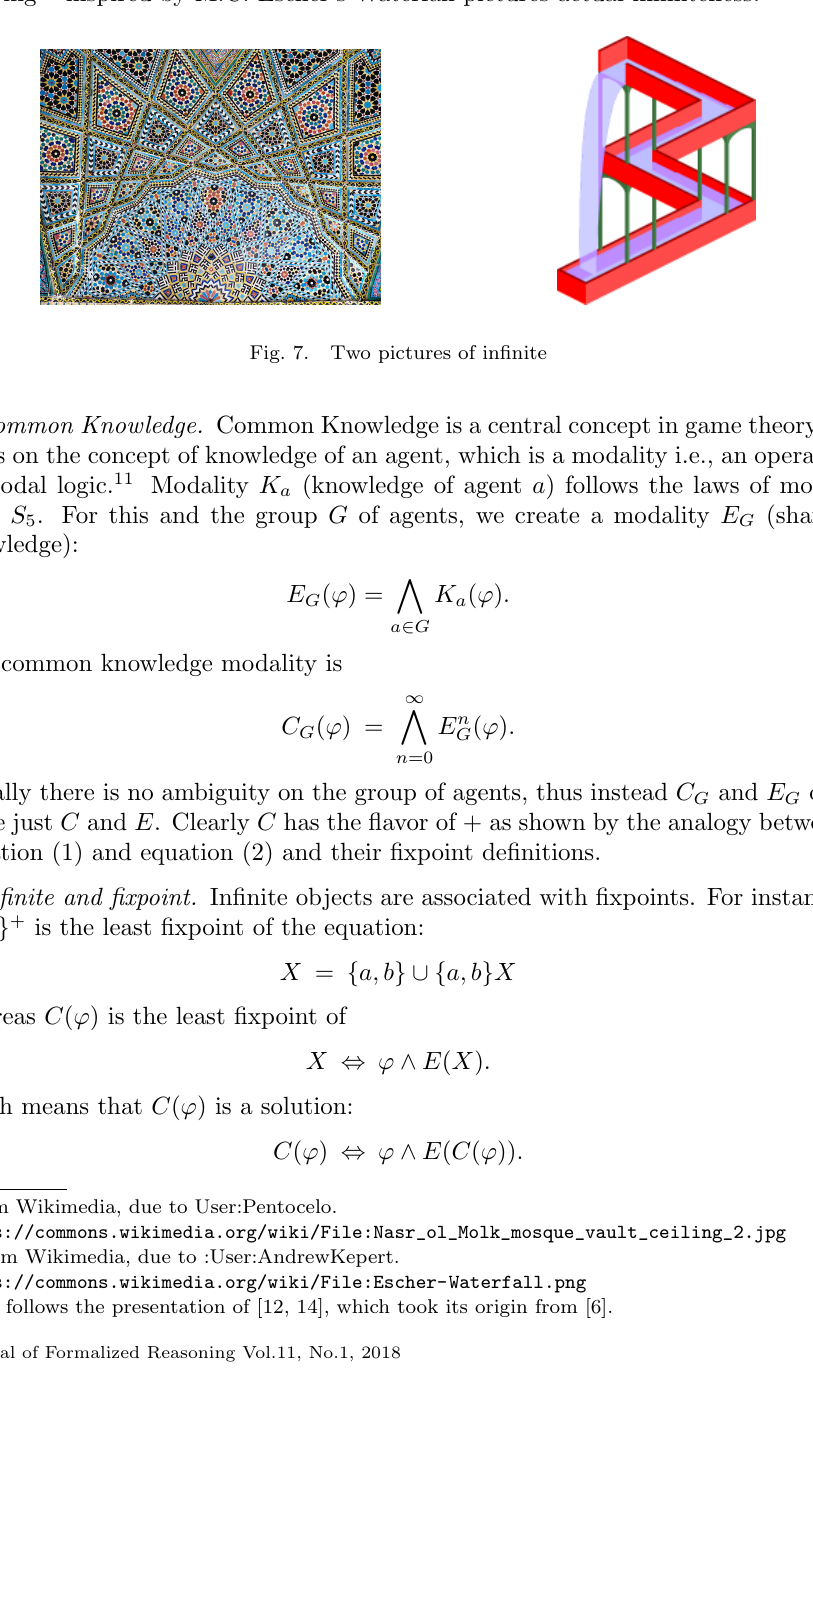
Figure 7 represents the two notions of infiniteness. On the left, the vault ceiling of Nasir ol Molk Mosque in Chiraz 9 pictures potential infiniteness. On the right, a drawing 10 inspired by M.C. Escher’s Waterfall pictures actual infiniteness.